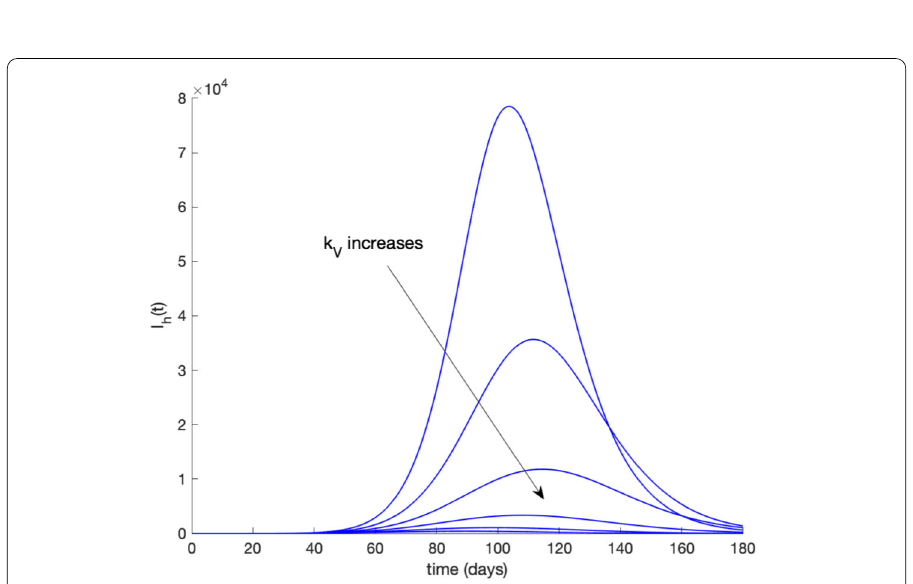
Figure 10 Effect of vaccination gain k V on the number of hospitalized infectious. The vaccination gain varies between k V = 0.0005 and k V = 0.001. No treatment control is